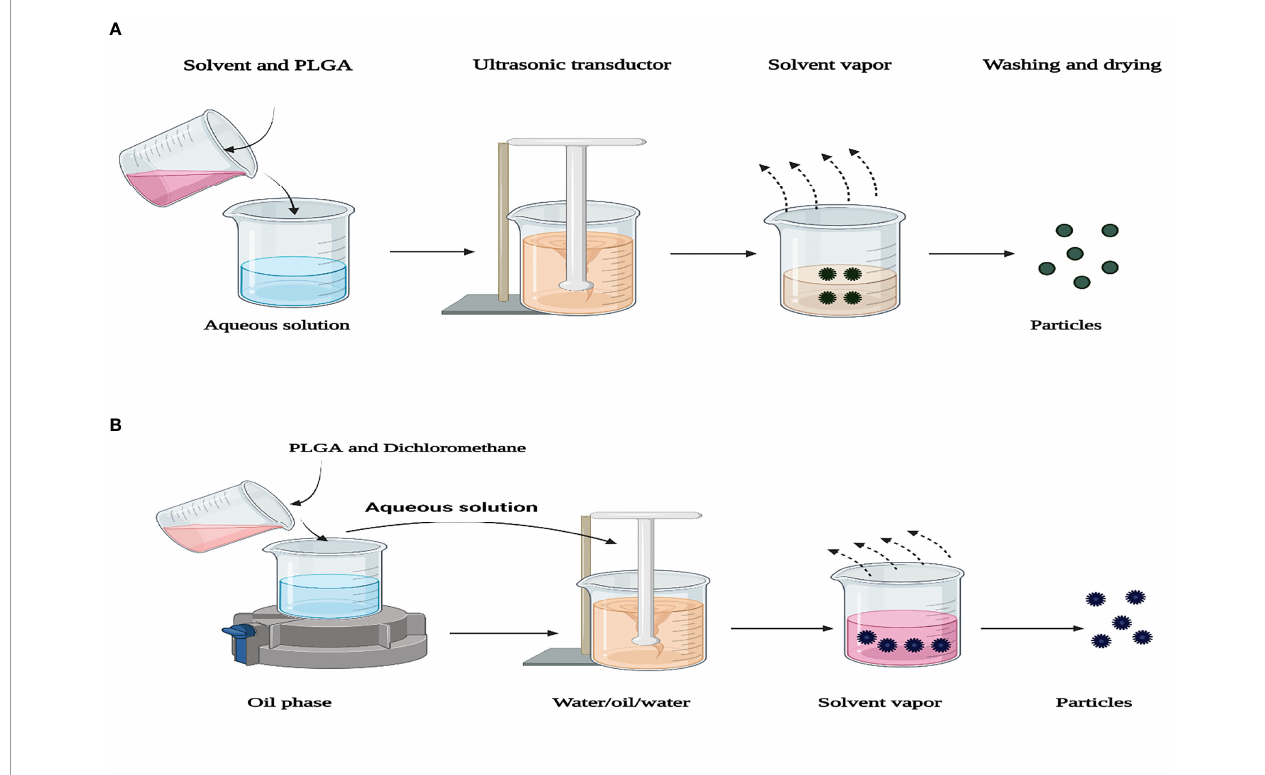
FIGURE 3 | Representation of two preparation techniques of PLGA particles. (A) Single-emulsion solvent evaporation. (B) Encapsulation of a drug into PLGA nanoparticles using double-emulsion solvent